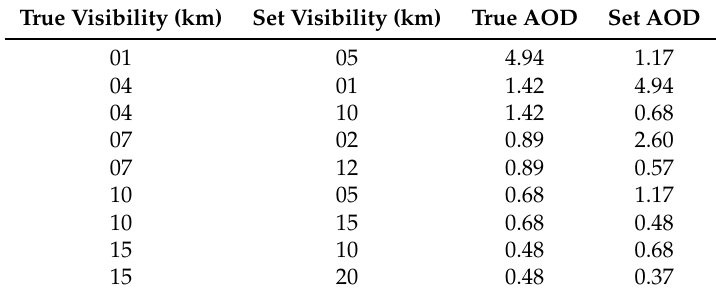
Table 2. True visibility values and visibility values used for estimating reflectance, and corresponding AOD values with column water vapor equals 2.0 g cm − 2 .